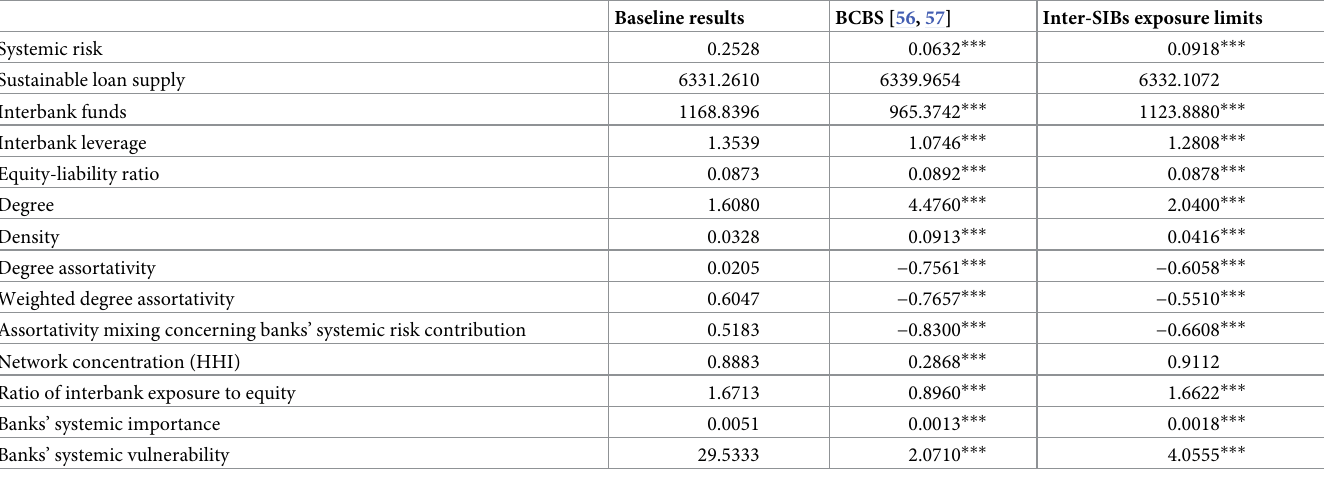
Table 5. Annually average results with interbank exposure